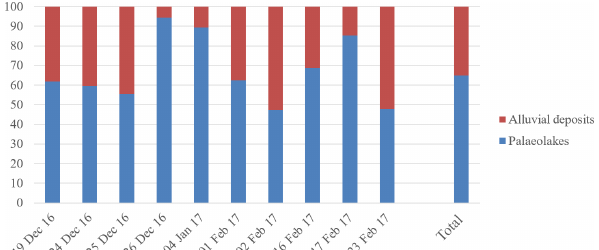
Figure 4. Contribution (in %) of palaeolake dust sources versus al- luvial deposit dust sources to total dust mass for the 10 largest dust storm events of the 2016–2017 winter dust season. sources had no clear distinguishable features to place them in one of the geomorphic categories, and were thus labelled as